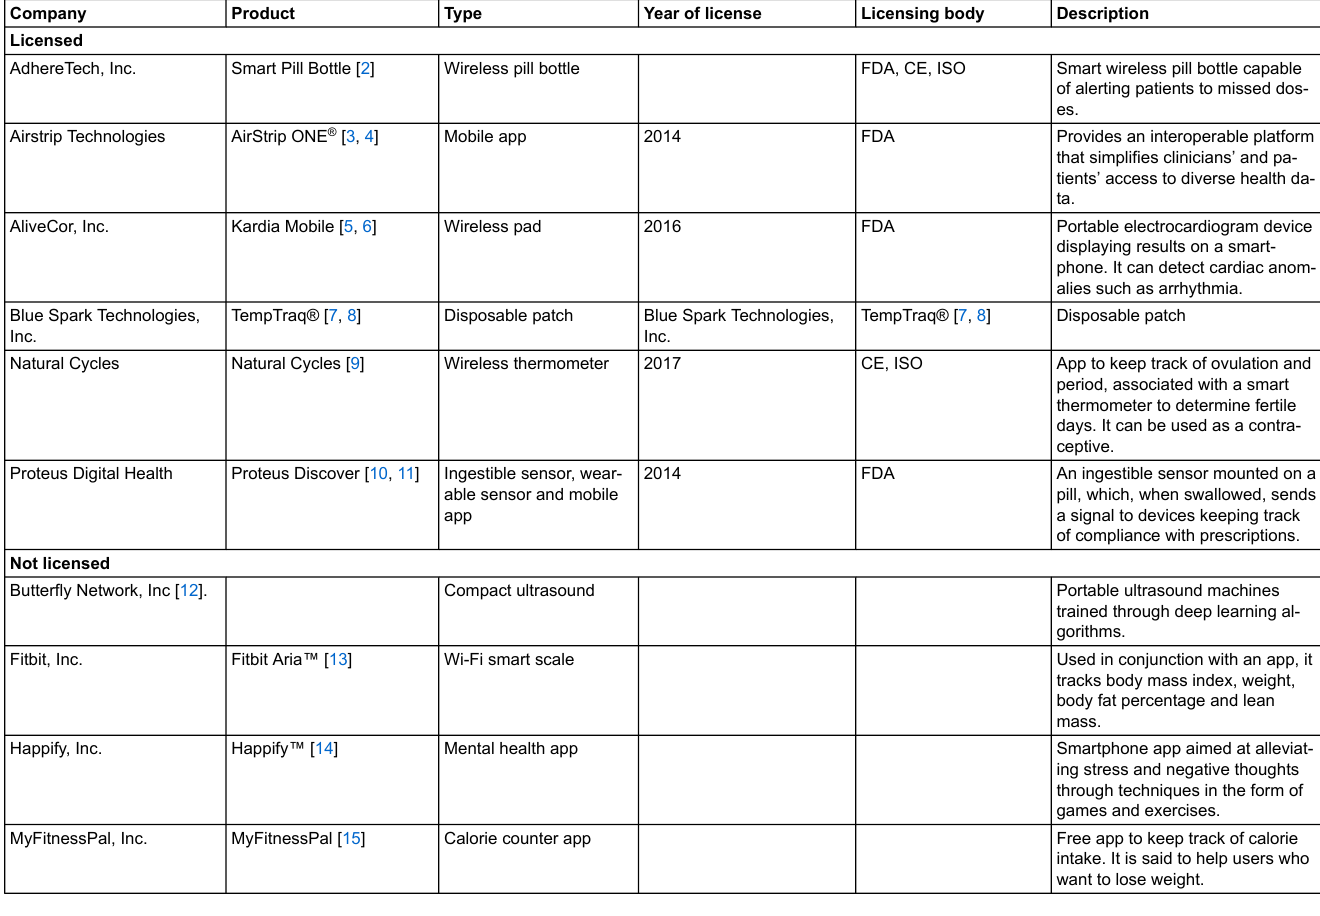
Table 1: Examples of licensed and unlicensed digital health technologies.